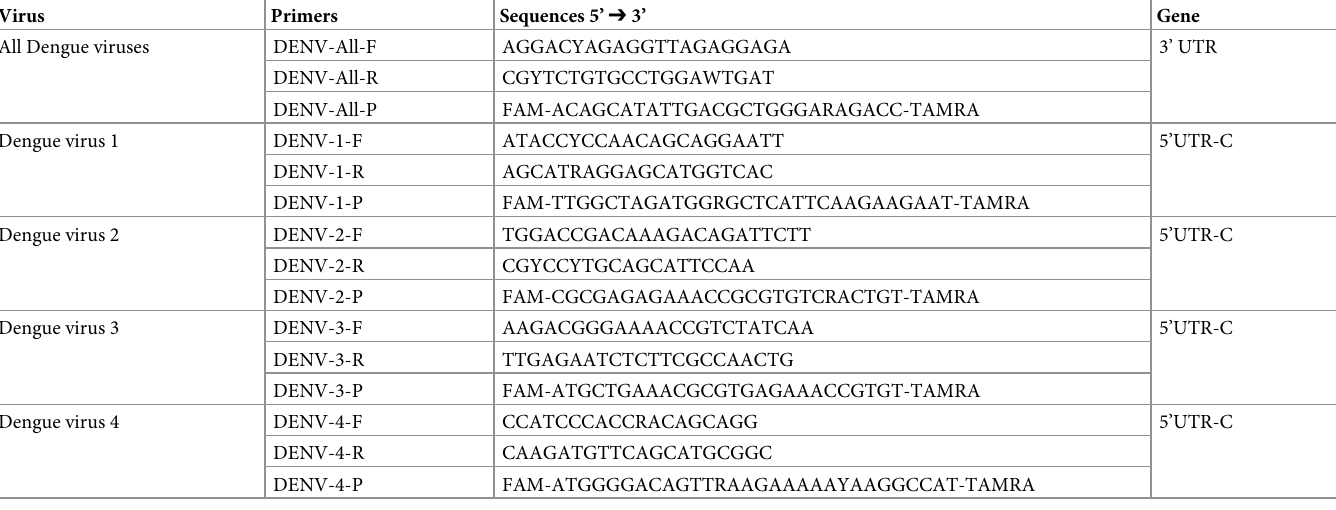
Adapted from Leparc-Goffart et al.,